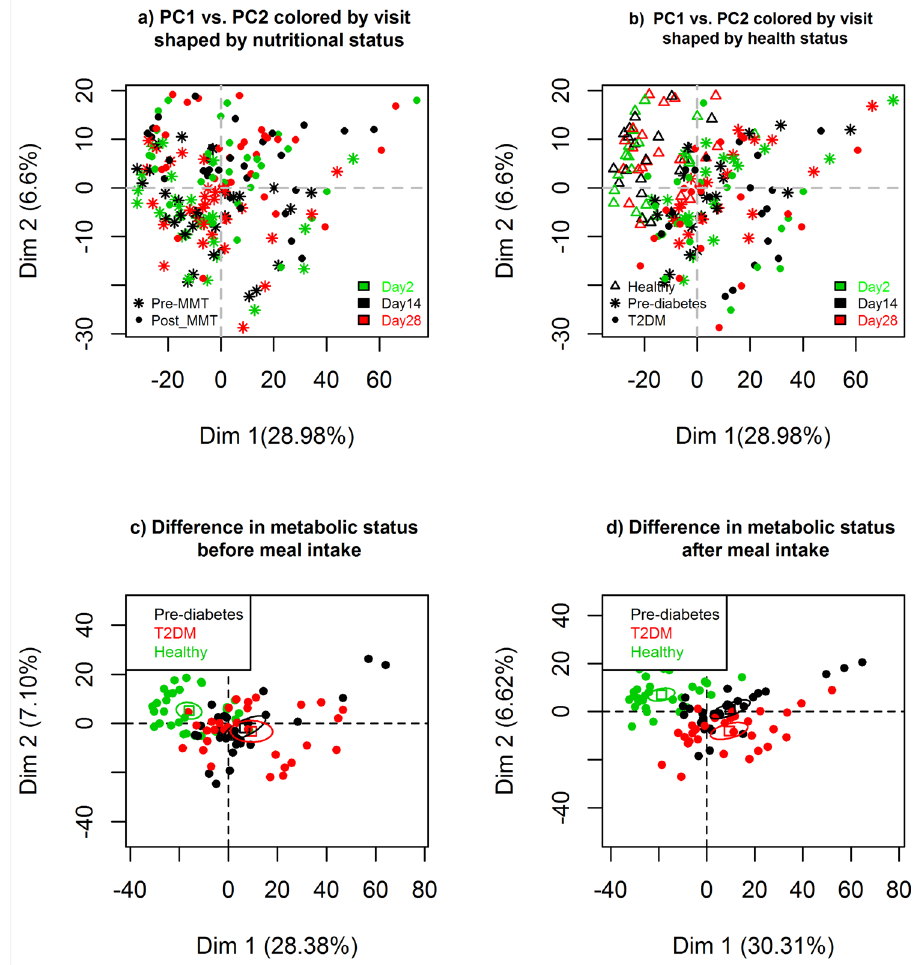
Figure 4. Principal component analyses for differences in metabolite levels between study days ( a , b ) or health groups ( c , d ). Colors and symbols refer to different study days, health groups or nutritional status as described in the diagrams.